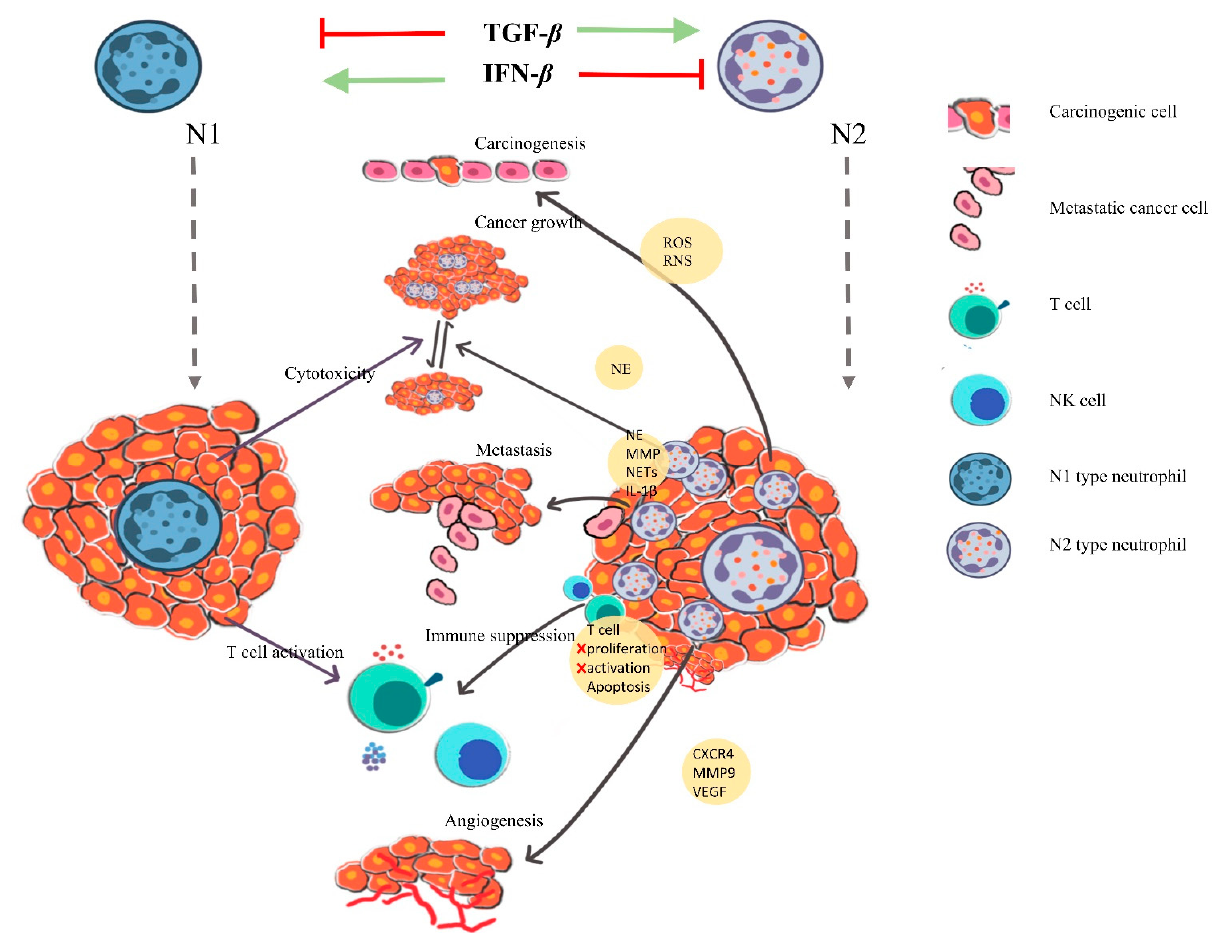
Figure 2. Role-dependent differentiation of neutrophils (N1 and N2) in cancer: The polarization of neutrophils is induction-dependent, IFN- β for N1 and TGF- β for N2. N1 neutrophils are categorized as antitumor neutrophils based on their cytotoxicity and T cell activation characteristics. N2 neutrophils are protumor neutrophils that induce carcinogenesis via ROS and RNS pathway; impart cancer growth directed by neutrophil elastases, the MMPs, NETs, NE and IL-1 β ; and promote cancer cell metastasis. N2 phenotype also suppresses T cell activation and proliferation, induces T cell apoptosis and inhibits NK cell activity; N2-type cells also participate in angiogenesis via CXCR4, MMP9 and VEGF expression modulation.